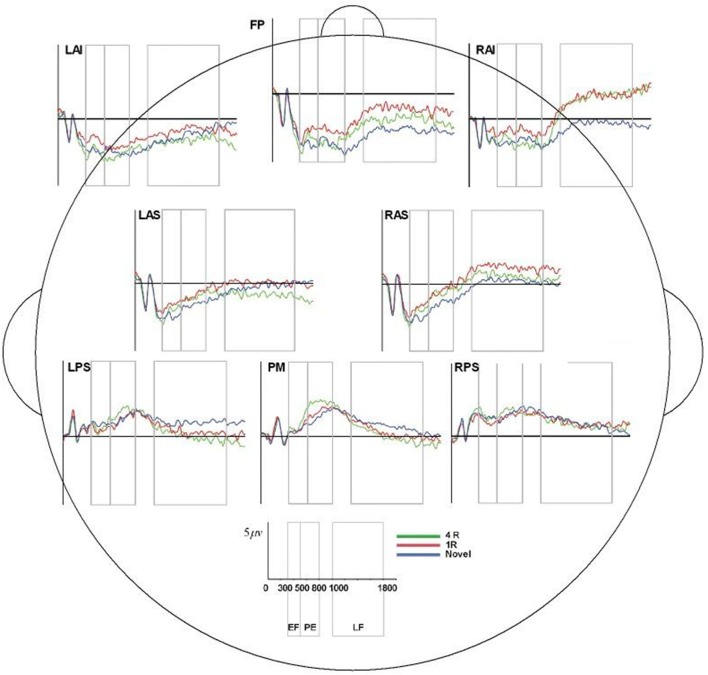
ERP, event-related potential; LAS, left anterior superior; FP, frontal pole; RAS, right anterior superior; LPS, left posterior superior; RPS, right posterior superior; PM, posterior medial; RAI, right anterior inferior; RAS, right anterior superior; 4R, presented 4 times; 1R, presented 1 time; N, Novel; EF, Early Frontal Effect, 300–500 ms; PE, Parietal Effect; 500–800 ms; LF, Late Frontal Effect; 1,000–1,800 ms. Average ERP wave forms for each region of interest (ROI) across the three conditions for processor C. X-axis represents time (in milliseconds) from 0 to 2,000, and Y-axis represents microvolts. Blue lines represent novel face-name (FN) pairs (correct rejections), red lines represent 1-time repeated (lR) FN pairs (hits), and green lines represent 4-times repeated (4R) FN pairs (hits).